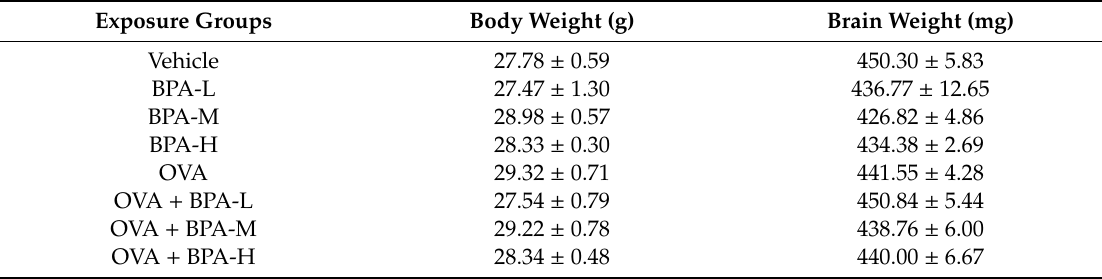
Table 1. Body weight and brain weight of eight experimental